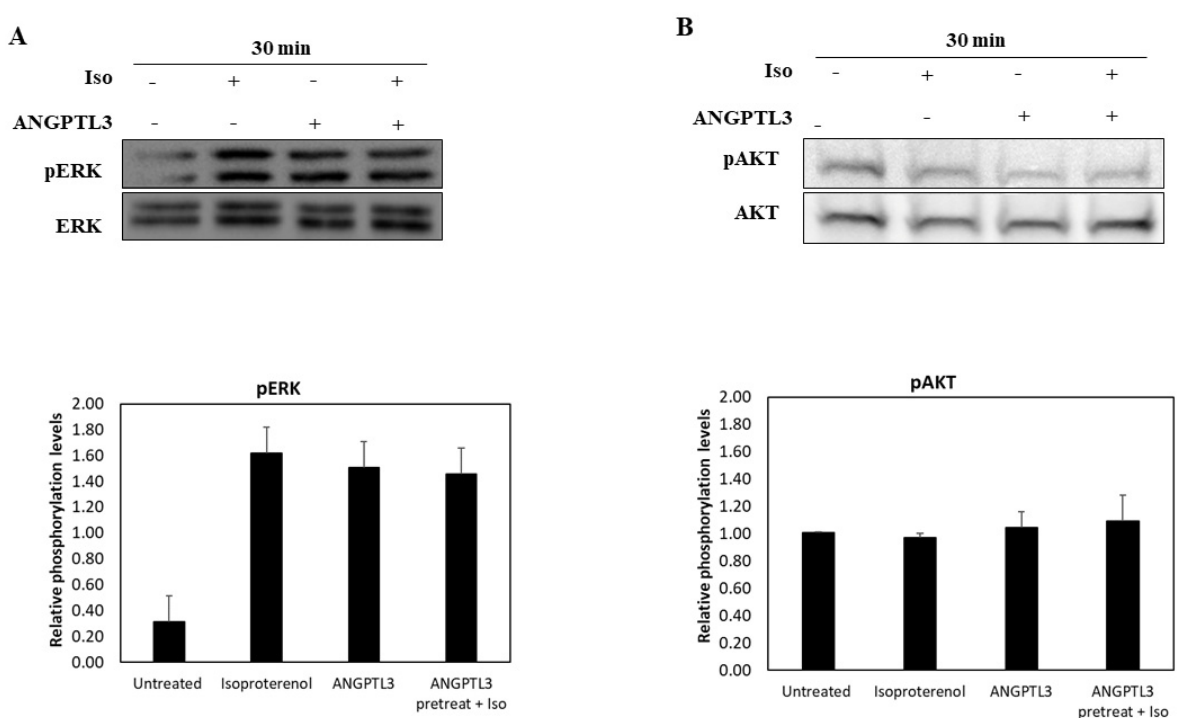
Figure 2. Intracellular kinase activation in ISO and ANGPTL3-treated cells. Representative blots of phosphorylated and total levels of ERK ( A ), AKT ( B ), in 3T3-L1 adipocytes treated for 30 min with recombinant human ANGPTL3 (ANGPTL3), ISO (Iso), and both. GAPDH levels were used as the loading control. Significant differences by t -test: